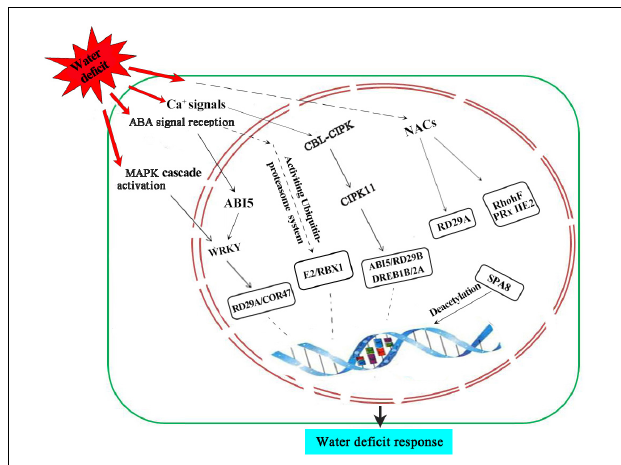
FIGURE 6 | A putative synergistic responsive network of the wheat grain proteome to water-deficit stress. SnRK2, suc non-fermentation-related kinases; CIPK11, CBL protein-interacting protein kinase